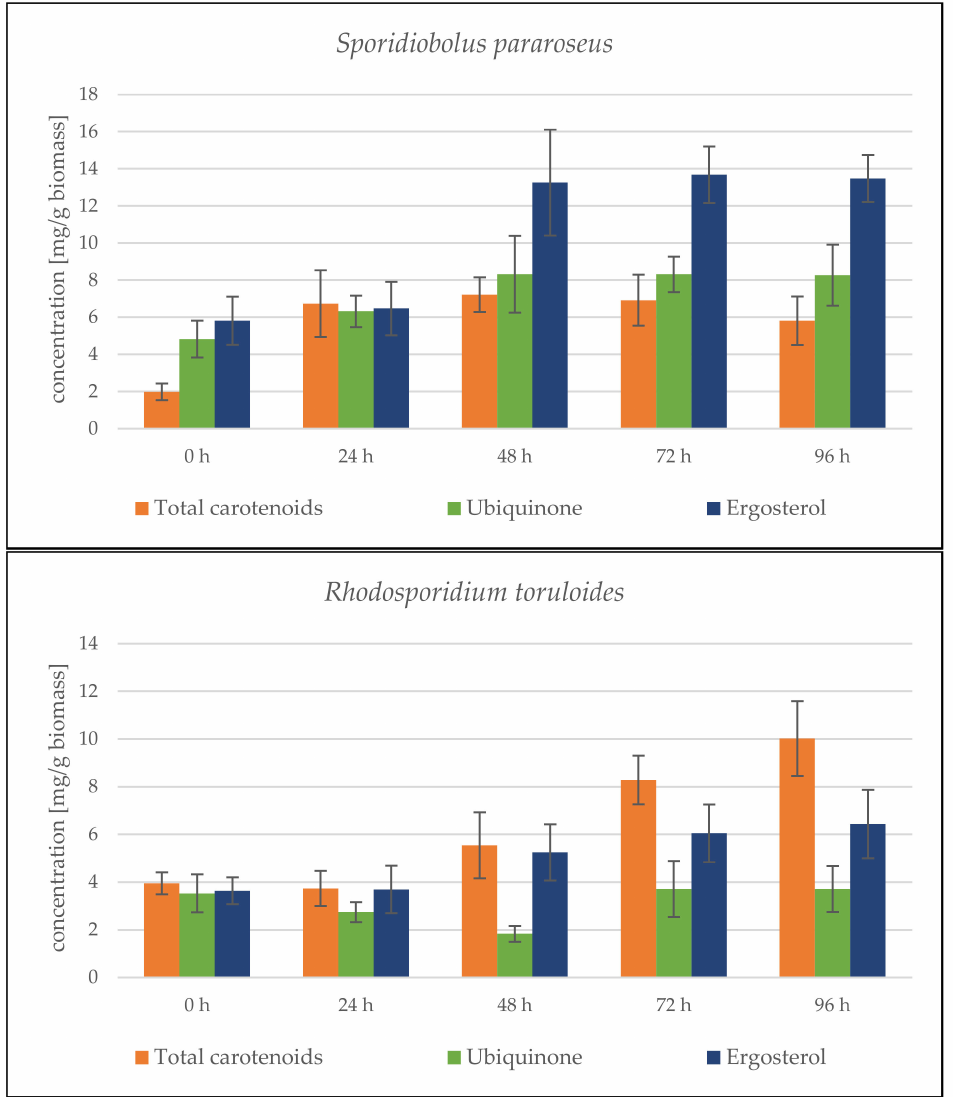
Figure 4. HPLC analysis of Sporidiobolus pararoseus and Rhodosporidium toruloides : 96 h bioreactor cultivation on SCG hydrolysate + coffee